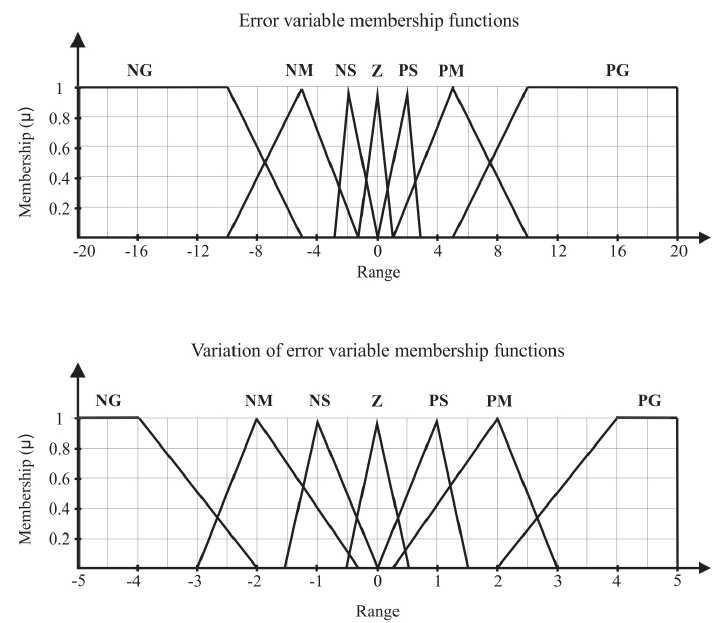
Figure 5. Membership function of the error and error variation input